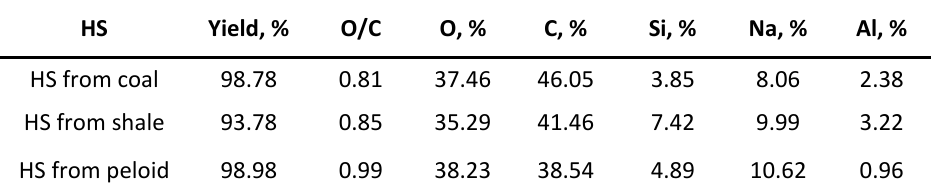
Table 5. Elemental composition of humic substances after